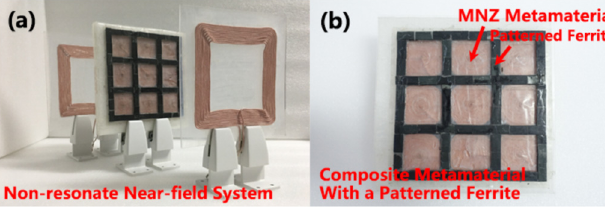
Fig. 4. (a) Experimental setup of non-resonant near- fi eld system and composite metamaterial with a patterned ferrite. (b) shows the details of composite metamaterial with patterned